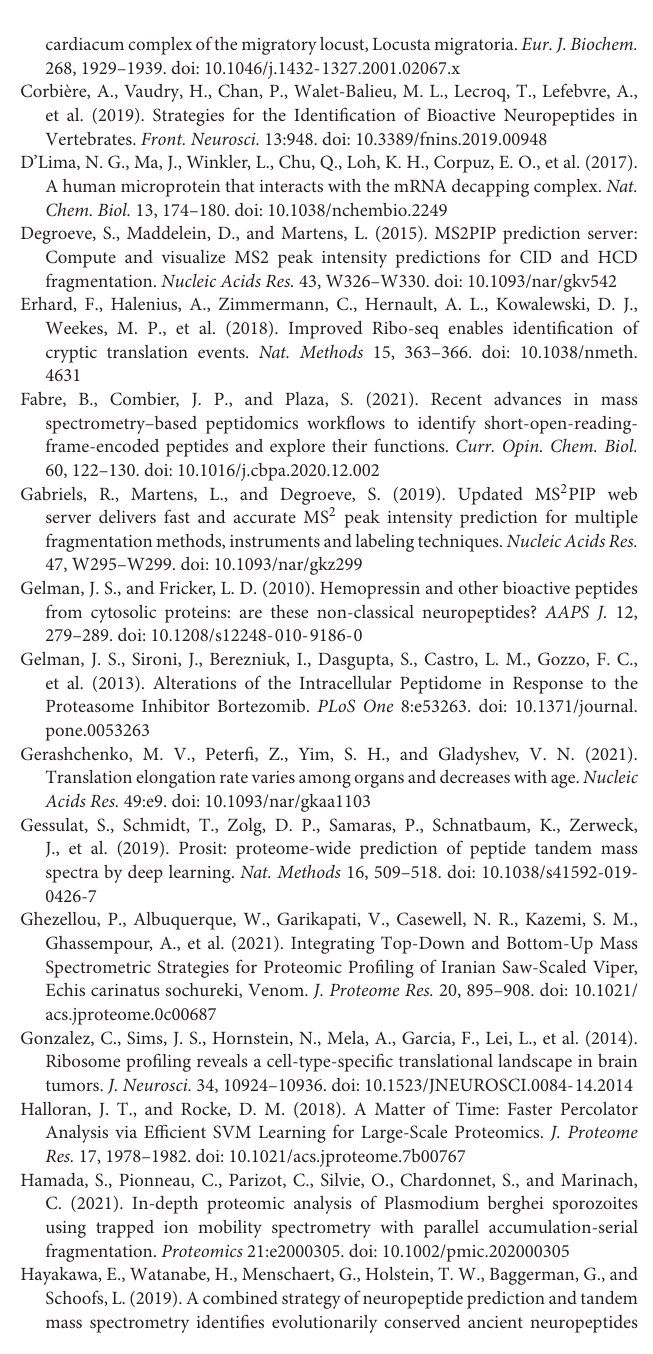
Supplementary Figure 5 | Impact of feature prediction on PSM level for anterior brain section. Supplementary Figure 6 | Impact of feature prediction on PSM level for cerebellum brain section. Supplementary Figure 7 | Impact of feature prediction on PSM level for cortex brain section. Supplementary Figure 8 | Evaluation of the available MS 2 PIP models of the Pearson Correlation Coefficient for four different models, trained with tryptic peptides of different fragmentations (CID, HCD, TOF) and the non-tryptic model